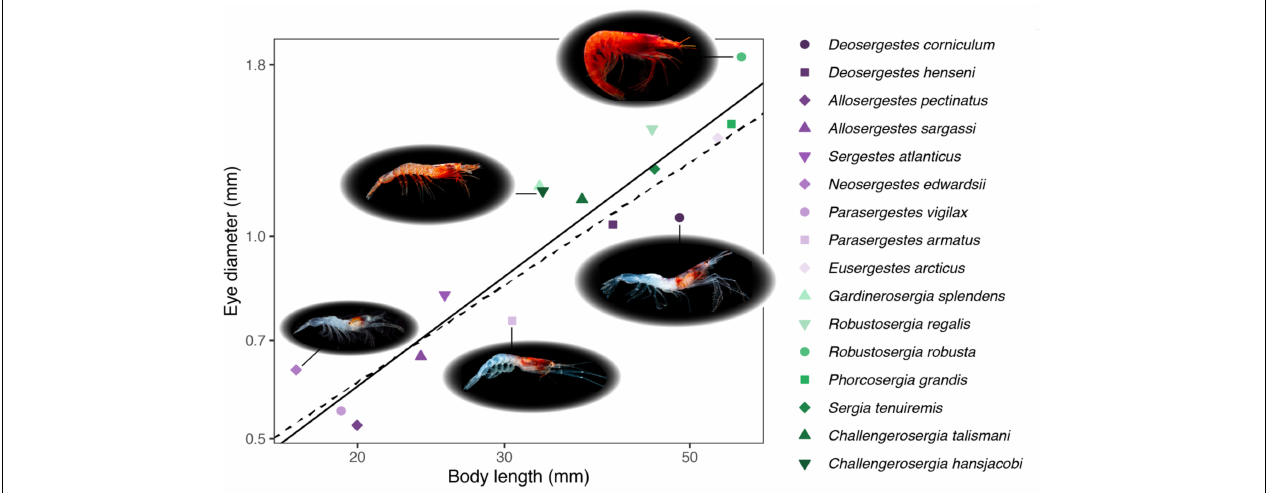
FIGURE 2 | Evolutionary allometry. Mean eye-body size allometry is shown for - sergia (green) and - sergestes (purple) groups of sergestid shrimps. Lines indicate phylogenetic generalized least squares (PGLS) regressions of log 10 eye diameter vs. log 10 body length. Models were run with λ set to either 0 (solid line) or 1 (dashed line), accounting for the lowest and highest bounds of phylogenetic signal in model residuals, respectively. Images represent a subset of sergestid shrimps and were used with permission from the photographer, ©DantéFenolio.